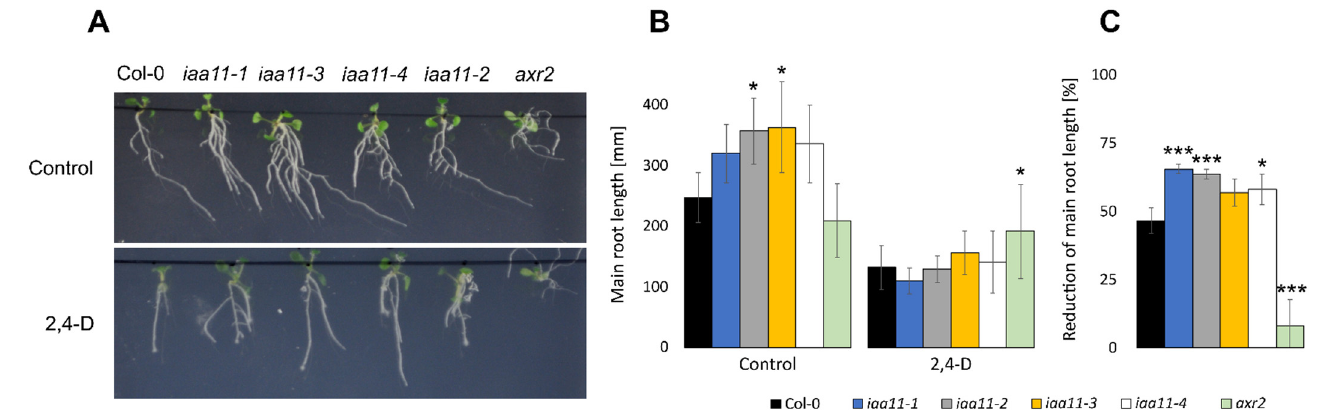
Figure 6. Aux/IAA11 is involved in auxin sensing. ( A ) Phenotype of 7-day-old Aux/IAA11 mutants and auxinresistant2 ( axr2 ) after treatment with 2,4-Dichlorophenoxyacetic acid (2,4-D). ( B ) Main root length of plants grown on ½ MS and on ½ MS supplemented with 10 nM of 2,4-D. ( C ) Reduction of the main root length of plants grown on 2,4-D compared to control conditions. n ≥ 6, Dunnet’s test (* p < 0.05; *** p < 0.001). Root lengths were measured using ImageJ software. Error bars